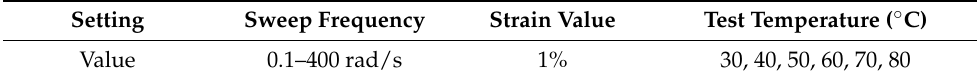
Table 4. Parameter